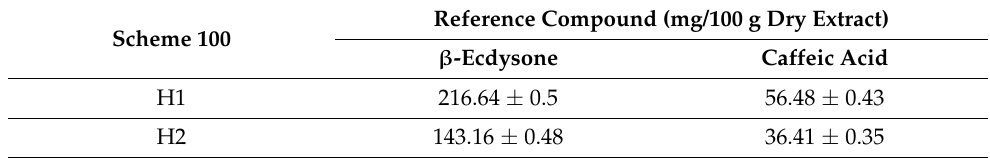
Table 1. Reference compounds identified in hellebore extracts by